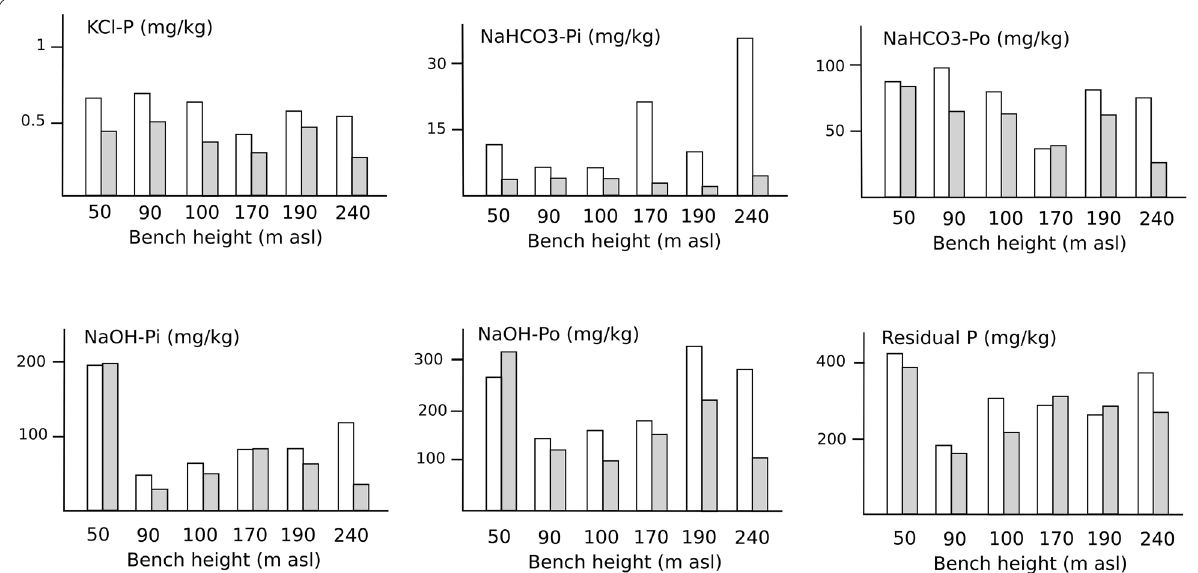
Fig. 3 P fractions (mg kg − 1 ) in non‑coral top‑ and sub‑soils in a ferralisation chronosequence on Green Island, Taiwan. Clear bars ‑ topsoil; Shaded bars ‑ diagnostic subsoil